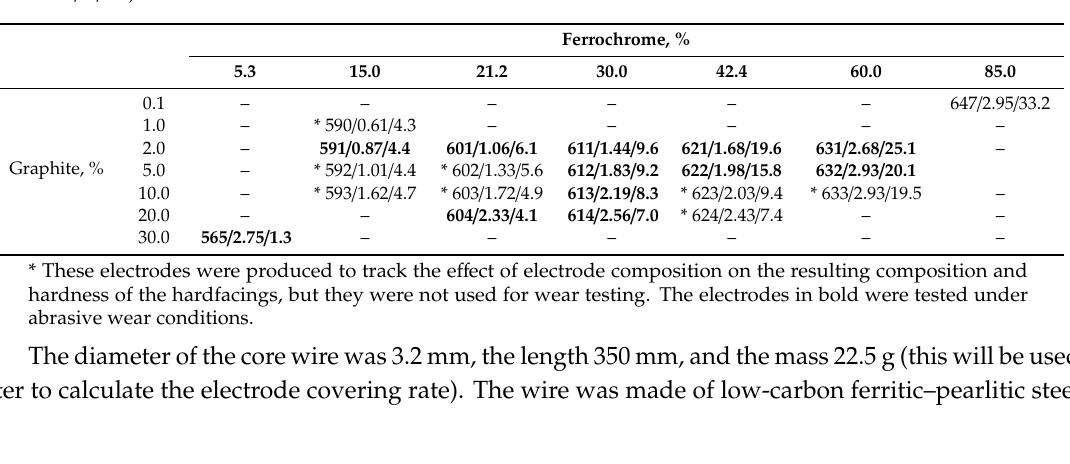
Figure 1. Breakdown of the main components and steps required to produce and estimate the economic feasibility of Fe–C–Cr manual arc-welded hardfacings. Table 1. Contents of graphite and ferrochrome in coverings of produced electrodes (dry powders). The contents (wt.%) of carbon and chromium in the produced hardfacings are also indicated (hardfacing code / C /